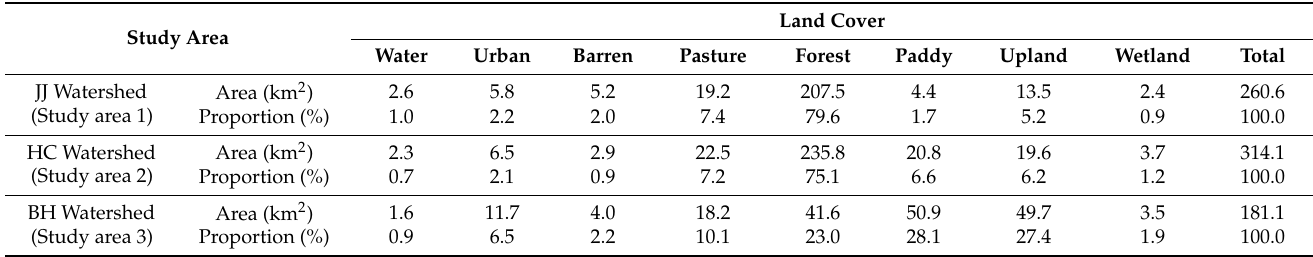
Table 1. Summary of the three study